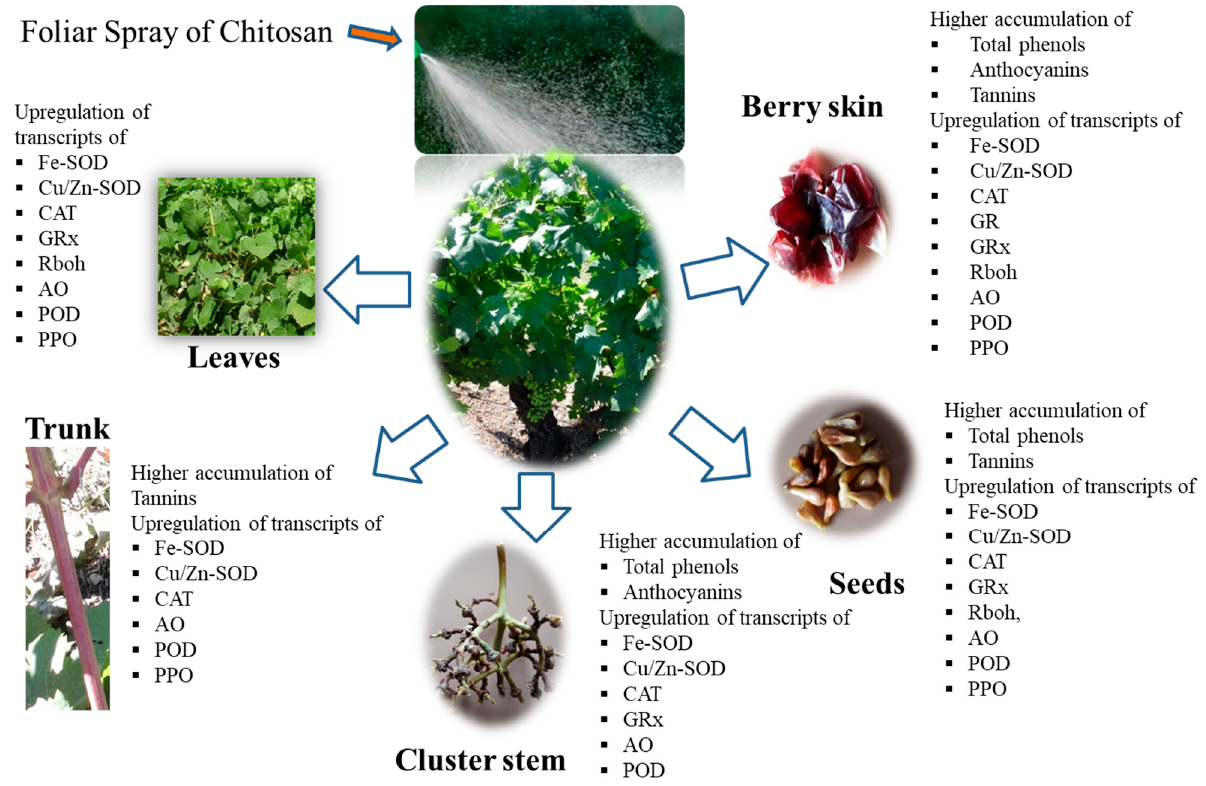
Figure 2. Diagrammatic representation of effect of chitosan application in grapevine in tissue specific manner at a molecular and biochemical level where different genes denominated as iron-superoxide dismutase (Fe-SOD), copper-zinc-superoxide dismutase (Cu/Zn-SOD), catalase (CAT), glutathione reductase (GR), glutaredoxin (Grx), respiratory burst oxidase (Rboh), amine oxidase (AO), peroxidase (POD) and polyphenol oxidase